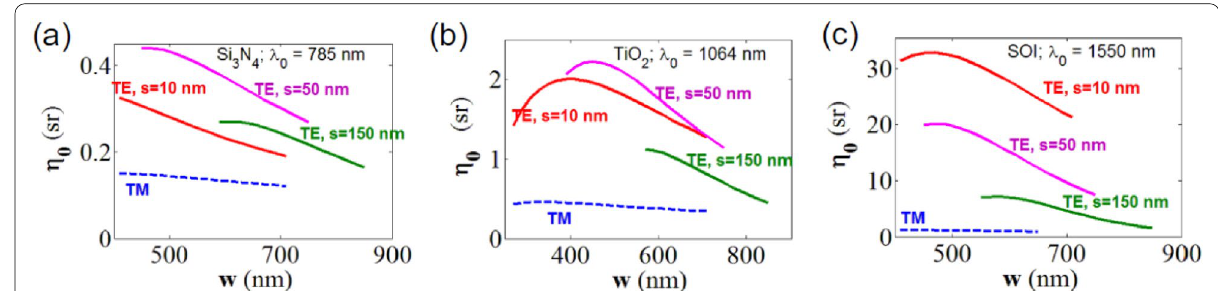
785 nm, b TiO 2 core with λ 0 1064 nm, c silicon core = =